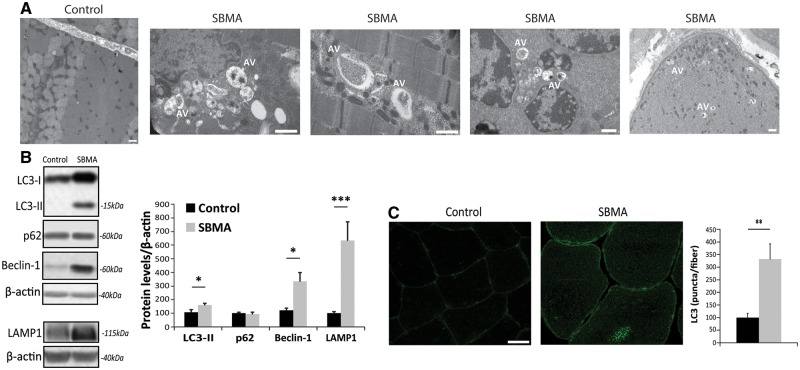
Increased autophagy in the muscle of SBMA patients. (A) TEM analysis of quadriceps muscle biopsies derived from two SBMA patients revealed the presence of autophagic vacuoles (AV). Scale bar, 1 μm. (B) Western blotting analysis of LC3-II, p62, Beclin-1 and LAMP1 levels. β-actin was used as loading control. Graph, mean ± SEM, n = 10 SBMA patients and 5 control subjects (top panels), and 9 SBMA patients and 9 control subjects (bottom panel). (C) Immunofluorescence analysis of LC3 in control and SBMA muscle tissues. The number of autophagosomes/fiber was measured as the number of green object-for-fiber (puncta/fiber). Graph, mean ± SEM, n = 50 fibers from each muscle sample derived from 11 SBMA patients and 10 control subjects. LC3 was detected using a specific antibody. Scale bar, 20 μm. Significance by Student’s t test: *P < 0.05, **P < 0.01, ***P < 0.001.